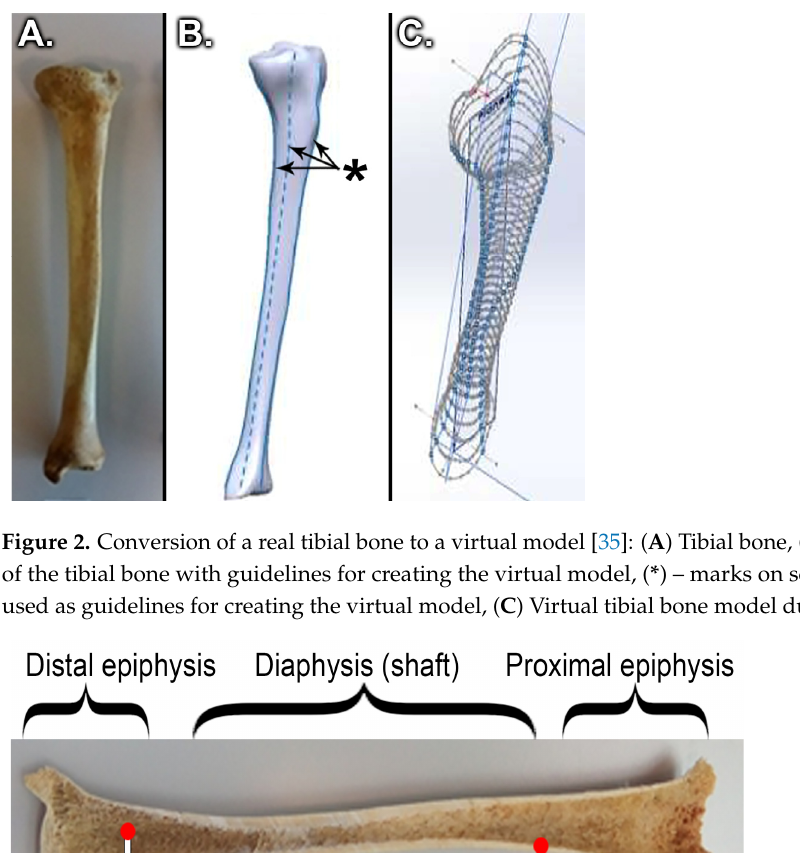
Table 1. Bone properties of virtual model.